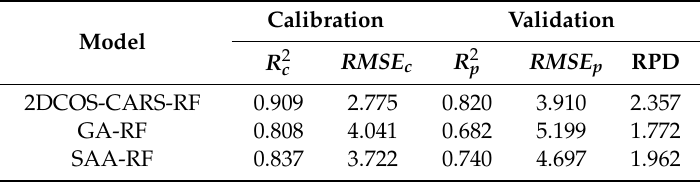
Table 2. Comparison of the prediction results of the three models.